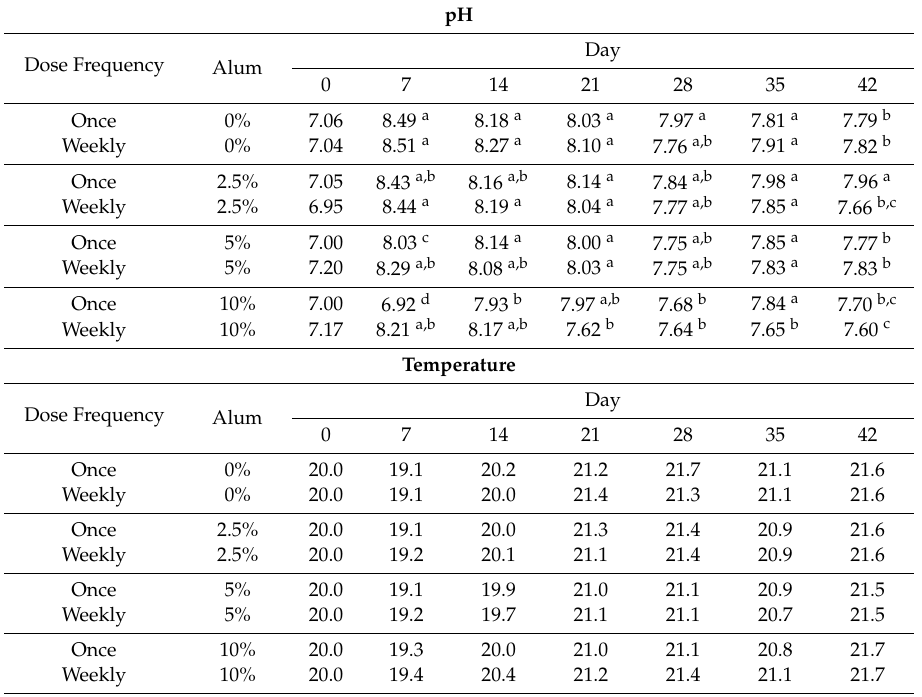
Table 1. Mean pH and temperature ( ◦ C) of bedded pack material on Day 0–42 following the addition of